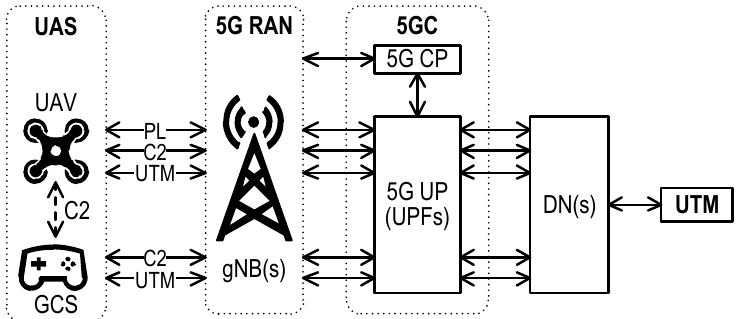
Figure 2. A simplified view on the UAS/UTM and 5GS entities (PL—payload, gNB—5G base